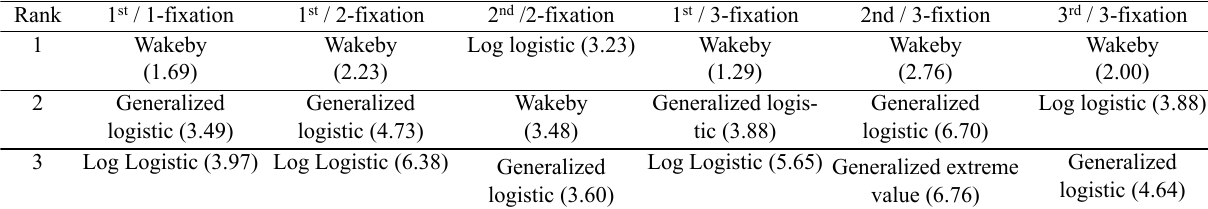
Table 3. Average rank order of fitted